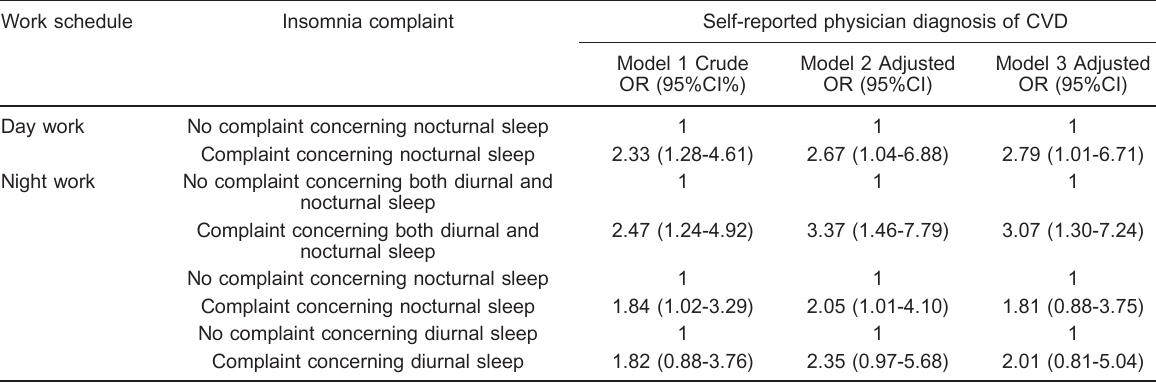
Table 3. Association between insomnia complaints and self-reported physician diagnosis of cardiovascular diseases among nursing professionals. Work